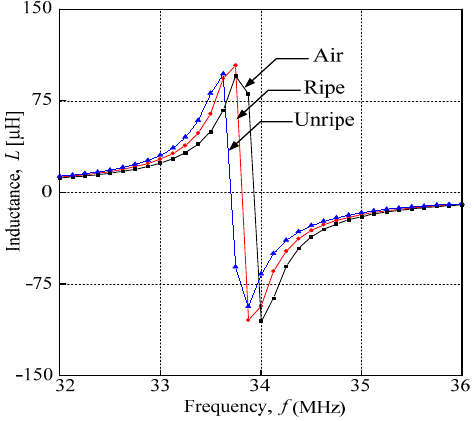
Figure 4. Oil palm fruit sensor inductance characteristics for air, ripe and unripe fruits.